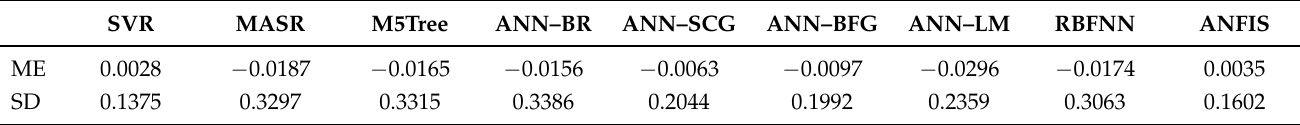
Table 8. The average prediction errors of ML approaches; see abbreviations in Nomenclature.